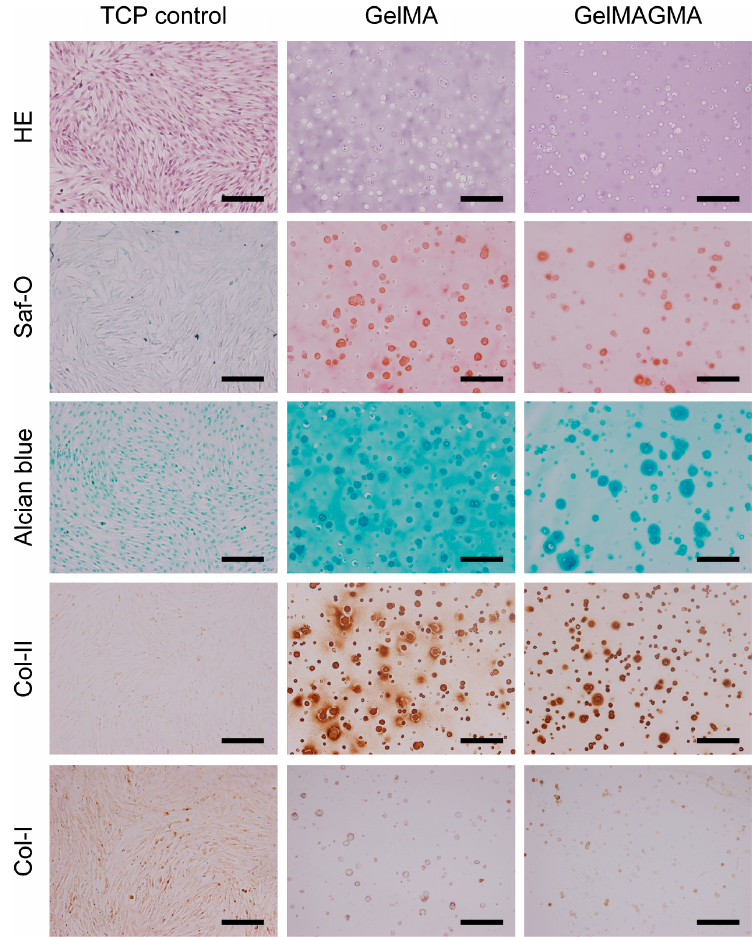
Figure 6. Hematoxylin and eosin (HE), safranin O (Saf-O), and alcian blue staining and immunohistochemical staining of collagen type II (Col-II) and collagen type I (Col-I) of the